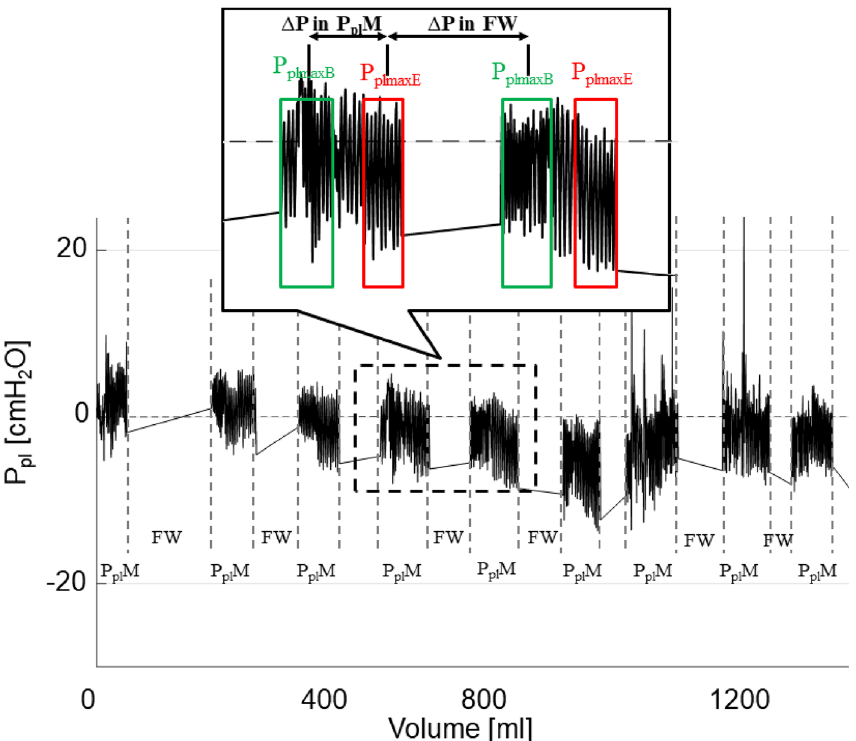
Figure 3. Graphic presentation of the method used to extract specific sections of the pleural pressure (P pl ) curve for the assessment of P plmax changes. P pl M- pleural pressure measurement period, FW–fluid withdrawal period, P plmaxB —maximal values of P pl at the beginning of P pl measurement period (the initial 2/5 of the entire P pl M), P plmaxE —maximal values of P pl at the end of P pl measurement period (the terminal 2/5 of the entire P pl M).